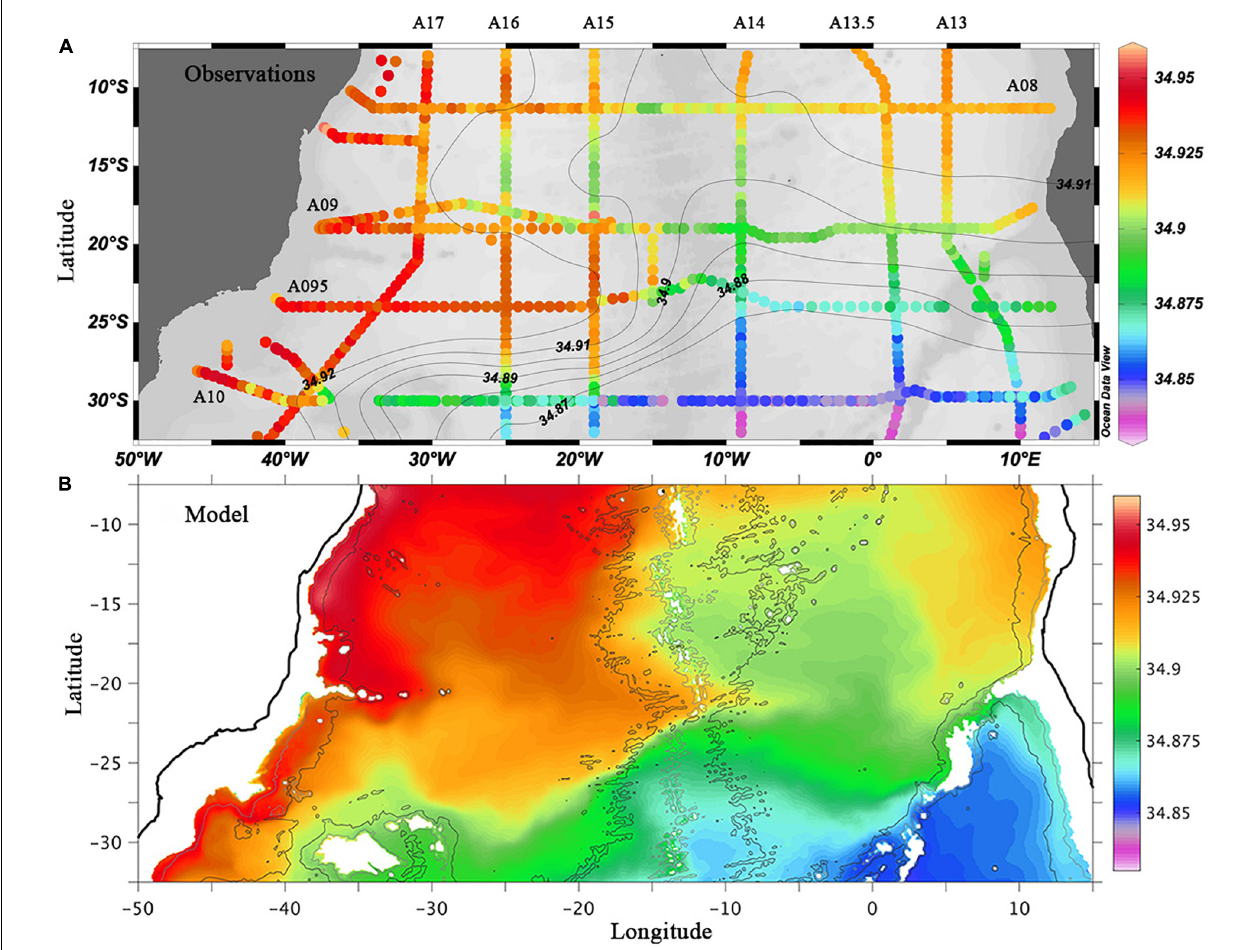
FIGURE 14 | Observed and modeled salinity distribution at 2500m in the South Atlantic. Observations are based on CTD data from GoShip program http://www.go-ship.org. Detailed vertical sections can be seen in the WOCE Atlas (Koltermann et al., 2011). The results show an eastward extension of high salinity (NADW signature) between 20 and 25 ◦ S west of the mid-Atlantic Ridge (MAR), and significantly lower salinity east of